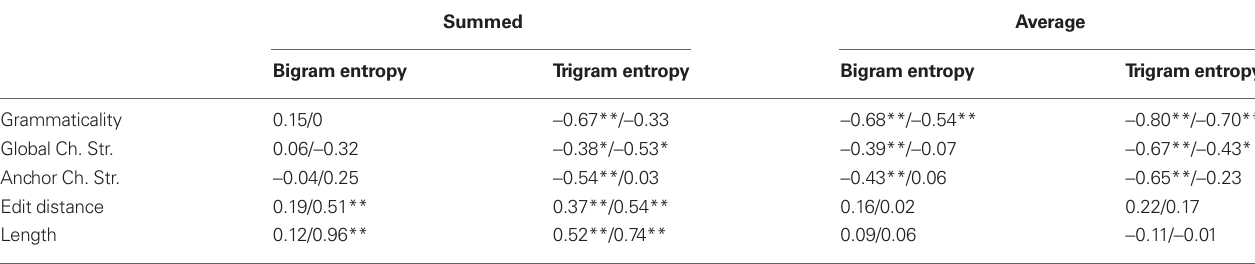
Table 2 | The correlations of the entropy measures and the other measures of AgL performance for the reber and Allen (1978) training, test stimulus sets and for the Knowlton and Squire (1996, exp. 1) training, test stimulus